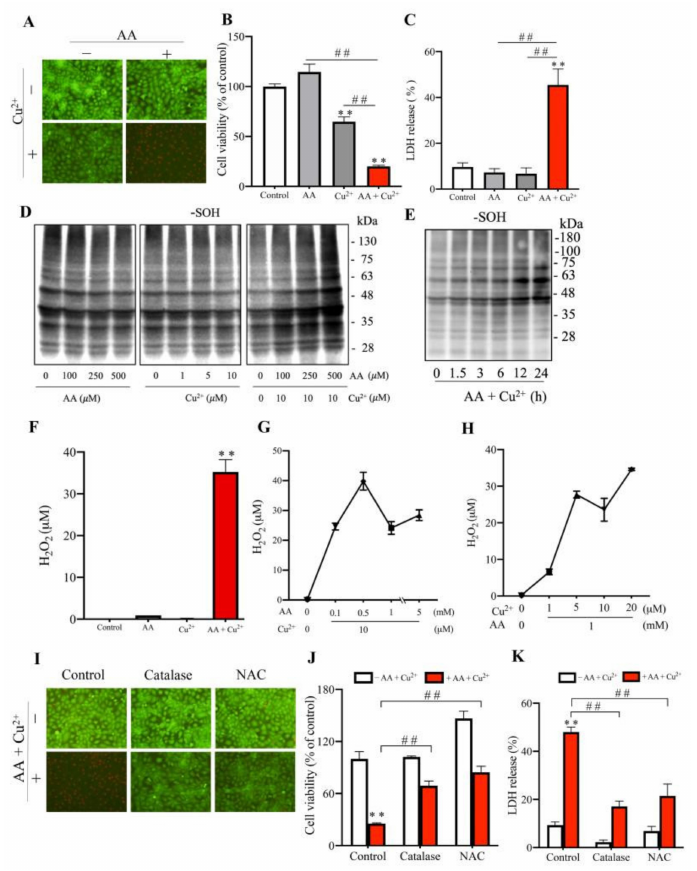
Figure 6. Effects of AA plus Cu 2+ on renal tubular viability and cellular oxidative status. ( A – C ) Effects of AA and Cu 2+ on renal tubular cell death. Renal tubular epithelial NRK cells were exposed to 1 mM AA, 10 µ M Cu 2+, or AA plus Cu 2+ in combination. The cell viability was evaluated by Red/Green staining ( A ), formazan formation ( B ) and LDH release ( C ). The data shown in ( B ) and ( C ) are expressed as relative changes against control in ( A ) and % of total LDH release in ( B ). Data shown are mean ± SE ( n = 4; ** p < 0.01; ## p < 0.01). ( D , E ) Effect of AA and Cu 2+ on protein oxidation. Cells were treated with the indicated concentrations of AA or Cu 2+ for 24 h ( D ), or 500 µ M AA and 10 µ M Cu 2+ for the indicated time ( E ). Cellular lysates were subjected to Western blot analysis for sulfenic acid formation. ( F – H ) Effect of AA and Cu 2+ coincubation on H 2 O 2 generation. One mM AA and 10 µ M Cu 2+ or the indicated concentrations of AA and Cu 2+ ( G , H ) were allowed to react for 30 min. The level of H 2 O 2 was measured using a commercial kit as described in the material and methods section. Data shown are mean ± SE ( n = 4; ** p < 0.01 vs. control). ( I – K ) The prevention of AA and Cu 2+ -induced renal tubular injury by antioxidants. Cells were exposed to AA plus Cu 2+ for 12 h in the presence or absence of 100 unit/mL catalase or 2 mM NAC. The cell viability was determined by red/green staining ( I ), formazan formation ( J ), and LDH release ( K ). The results shown in ( J , K ) are the percentage of control and percentage of 100% LDH release, respectively. Data shown are mean ± SE ( n = 4, ** p < 0.01; ## p <